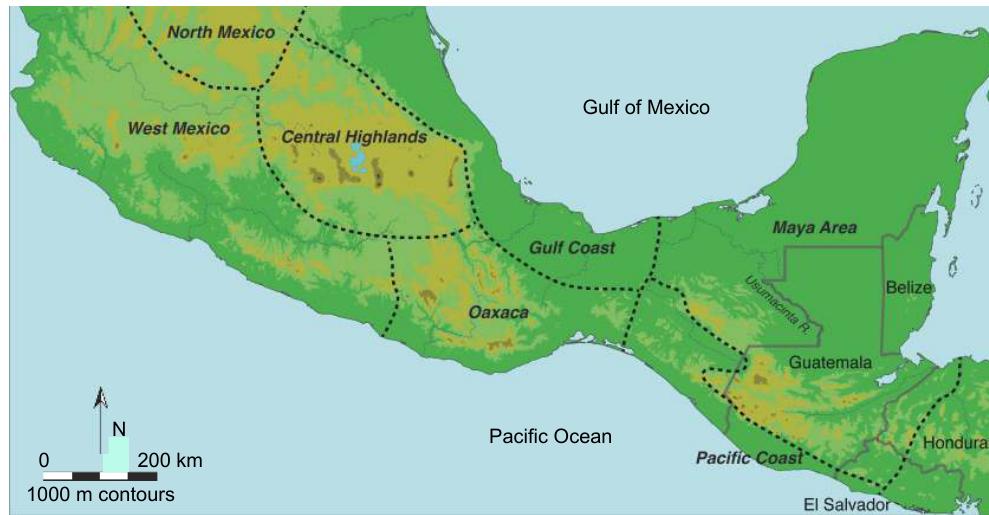
Fig. 1 Mesoamerica map with six